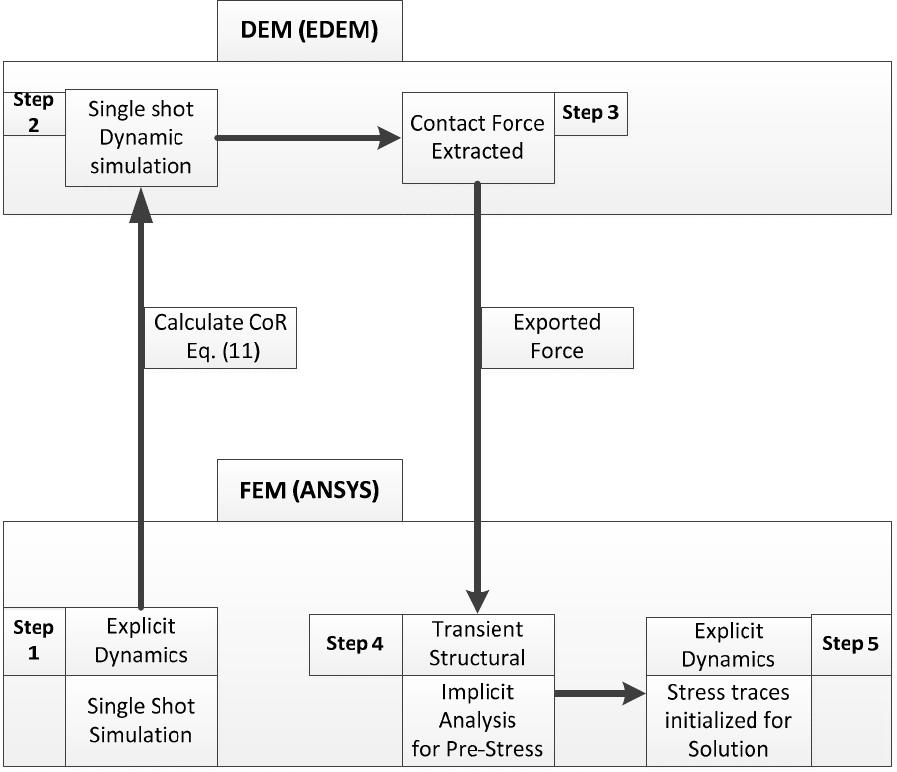
Figure 3. Data Flow between DEM and FEM.